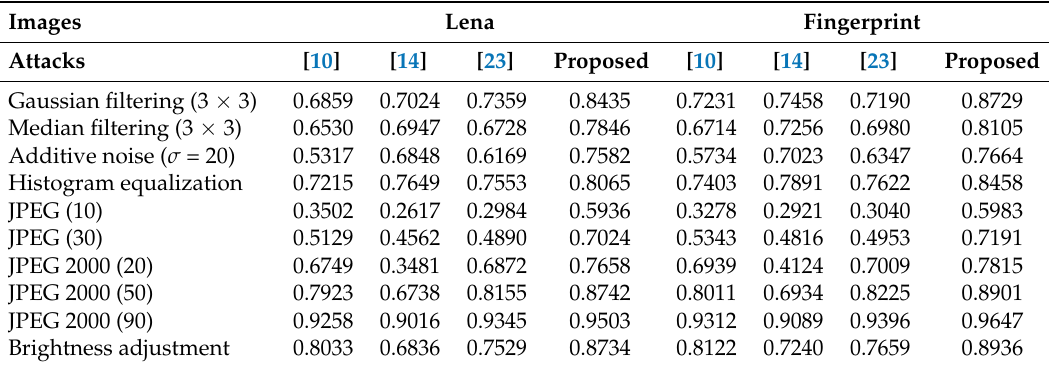
Table 3. The results of attack under image processing (NC).